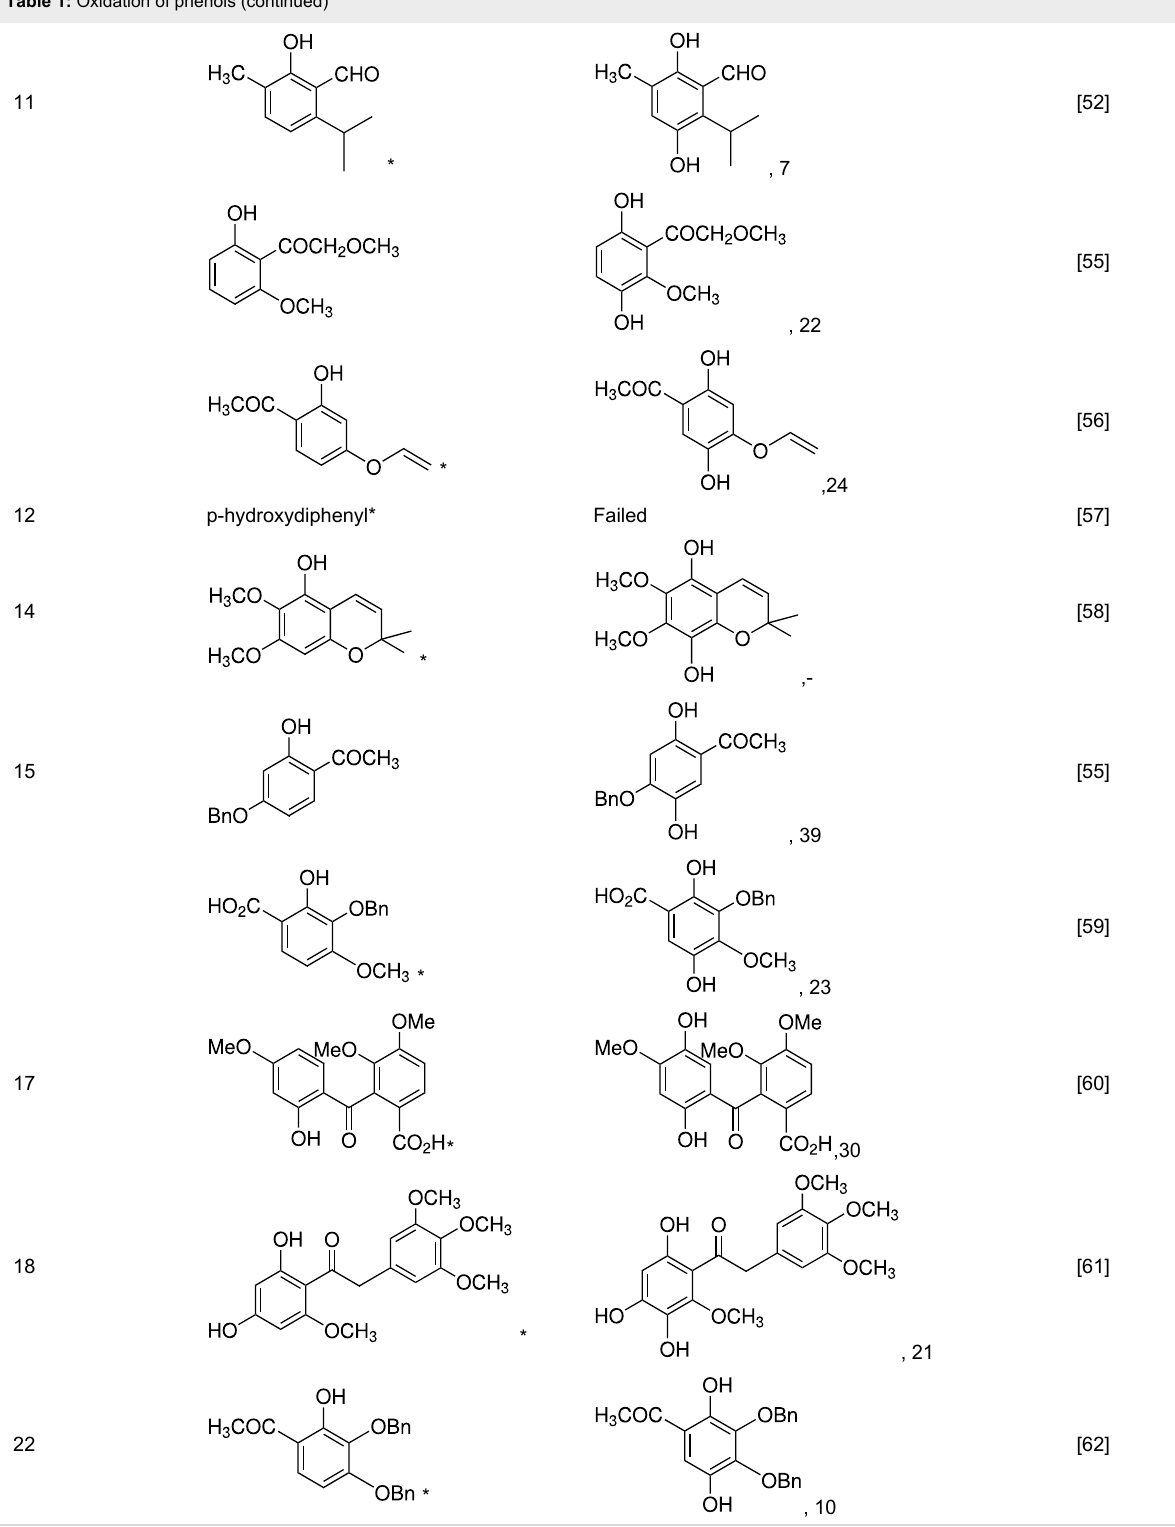
Table 1: Oxidation of phenols (continued)